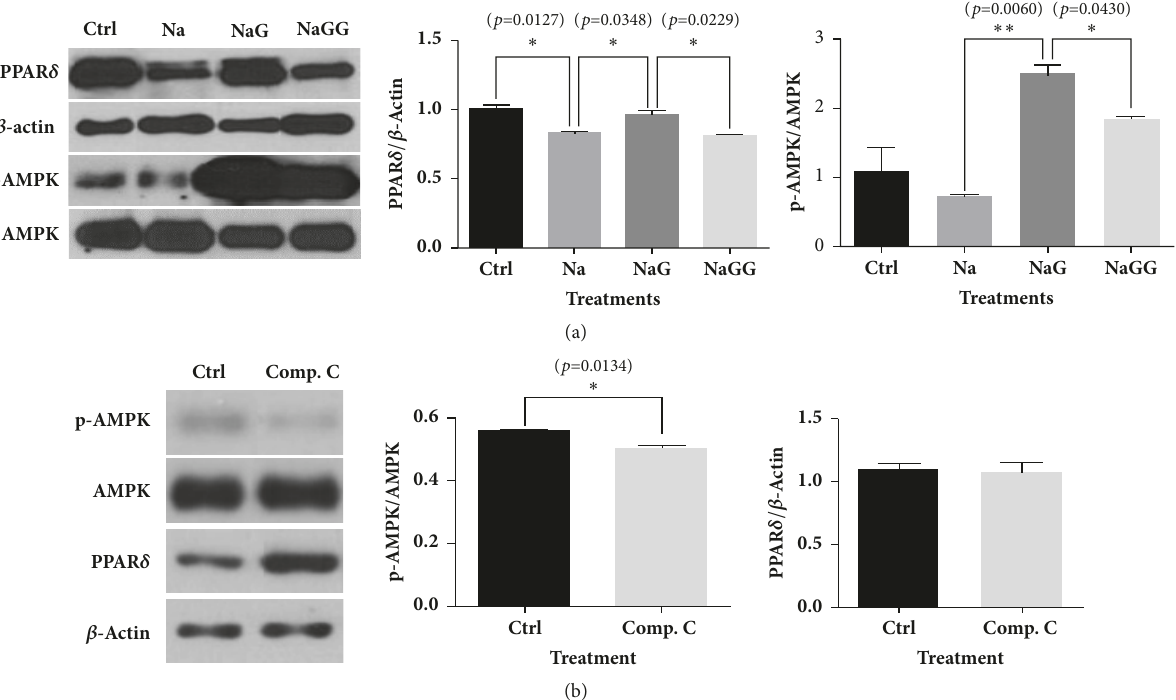
Figure 5: W estern b l o t anal y ses fo r PPAR 𝛿 an d AMP K in HEK293 cells treate d w it h NaCl , 6 - g in g er o l , an d GS K0660, o r treate d by c o m pou n d C. (a) 6-Gingerol normalized the abnormal expressions of PPAR 𝛿 and AMPK in HEK293 cells treated with NaCl. In addition, the effects of 6-gingerol were reversed by PPAR 𝛿 antagonist. (b) The AMPK antagonist, compound C, did not affect the protein level of PPAR in HEK293 cells. The results are expressed as means ± SEM (n=3). Values were statistically analyzed by unpaired t -test. All experiments were repeated three or more times. The statistical significance between the two experimental groups was marked as ∗ p < 0.05 and ∗∗ p < 0.01. Meaning of indications: Ctrl means untreated normal control group, Na means NaCl treated group, NaG means NaCl and 6-gingerol treated group, and NaGG means NaCl, 6-gingerol, and GSK0660 treated